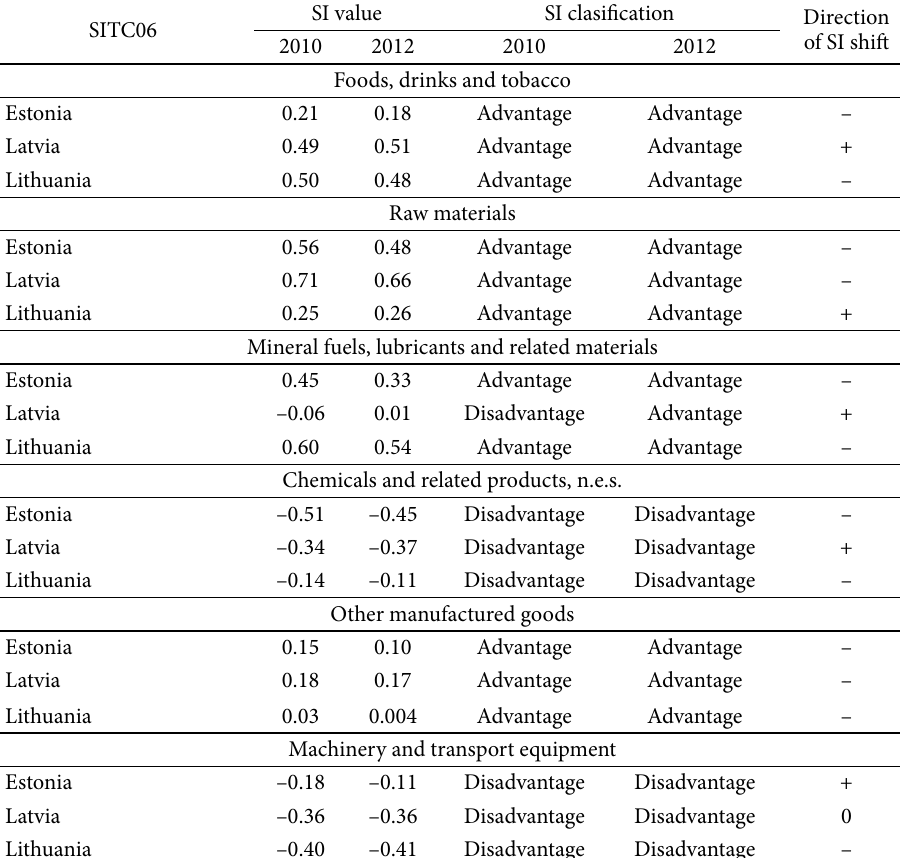
table 3. The results of sI index for the Baltic states sItC06